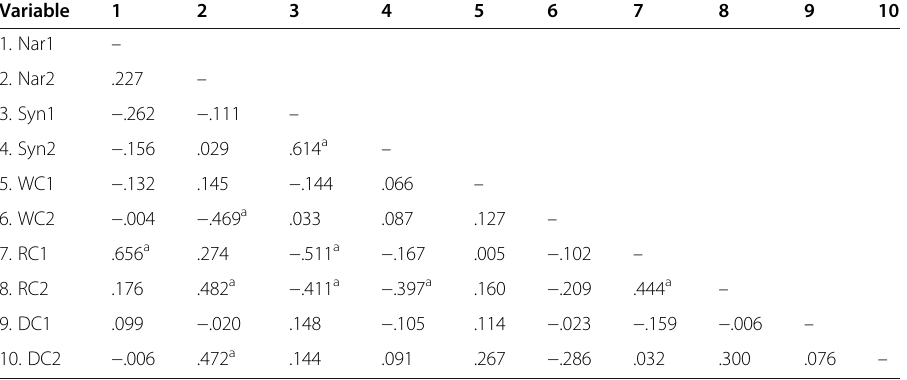
Table 8 Correlations between the components